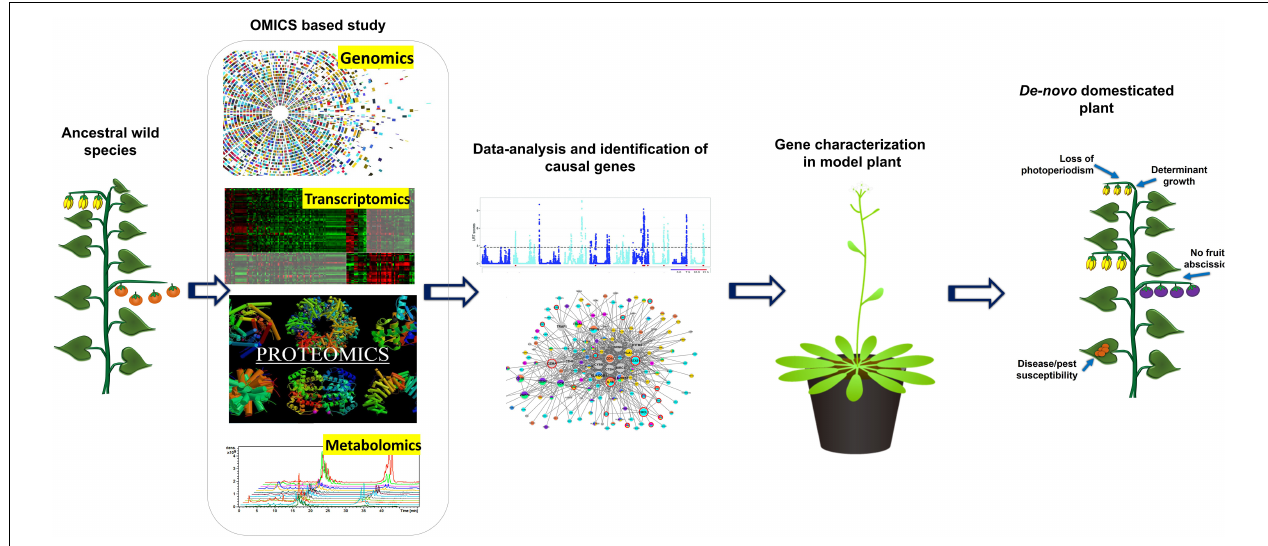
FIGURE 2 | Schematic diagram representing the role of OMICS based research in gene characterization and development of designer crops using de novo domesticated crops approach.